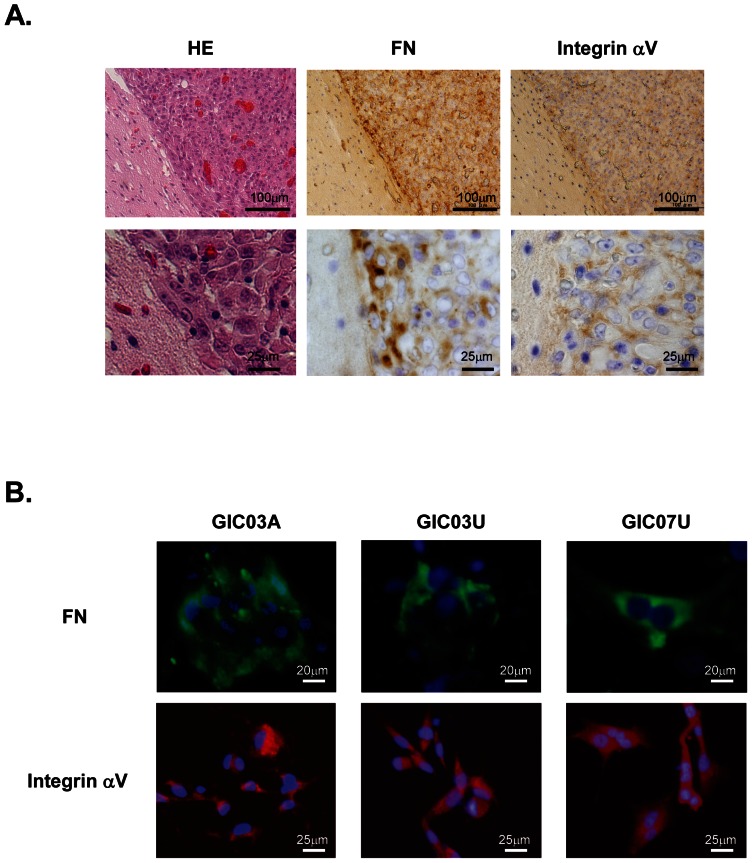
Fibronectin/integrin αV expression in glioblastomas developed from mouse brain GIC xenografts and differentiating GIC clones.
A. HE staining and immunohistochemical staining with anti-FN and -integrin αV antibodies of serial sections of a glioblastoma derived from a mouse brain GIC xenograft. The representative tissues were obtained from a glioblastoma in the brain at 39 days after the intracranial injection of GIC07U. B. Differentiating GIC03A, GIC03U and GIC07U were stained with anti-FN antibody (green, upper panel), DAPI (blue; upper panel), anti-integrin αV antibody (red; lower panel) and DAPI (purple; lower panel) after 5 day's serum stimulation. All of GIC clones possess cytoplasmic expression of FN and membrane expression of integrin αV.